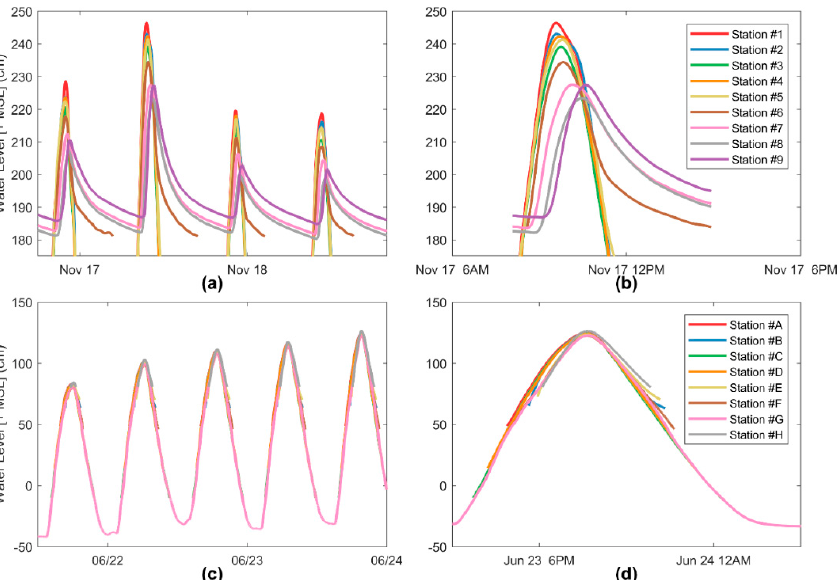
Figure 5. ( a ) The Firth of Thames water level at each instrument station for five consecutive spring tidal cycles. The upper intertidal flat (stations #6–#9) did not fully drain for several tidal cycles; ( b ) Firth of Thames water level during maximum inundation event; ( c ) Tauranga water level for five consecutive spring tidal cycles. Note that only station #G was submerged at low tide; ( d ) Tauranga water level during the largest tidal cycle.